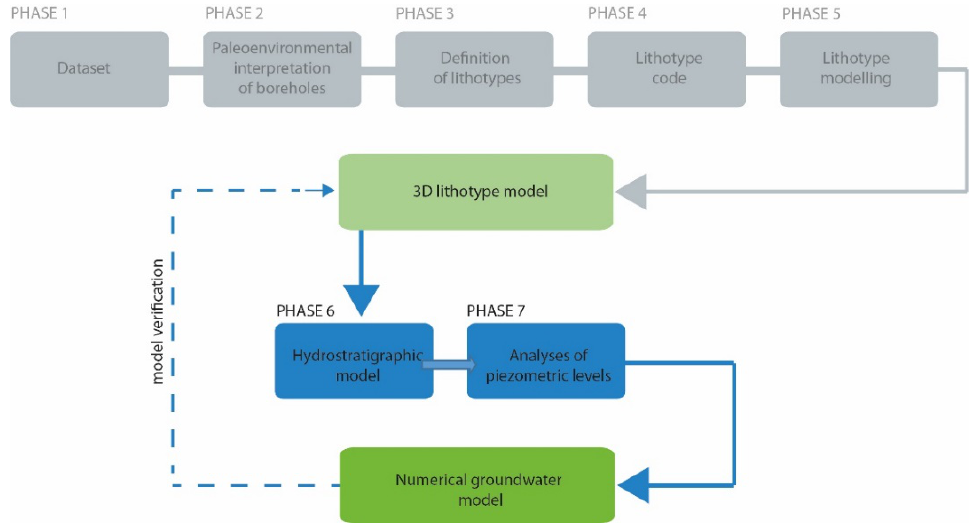
Figure 13. Flowchart showing the iterative process described in this study. The 3D lithotype model and the numerical groundwater model constitute the main outputs.